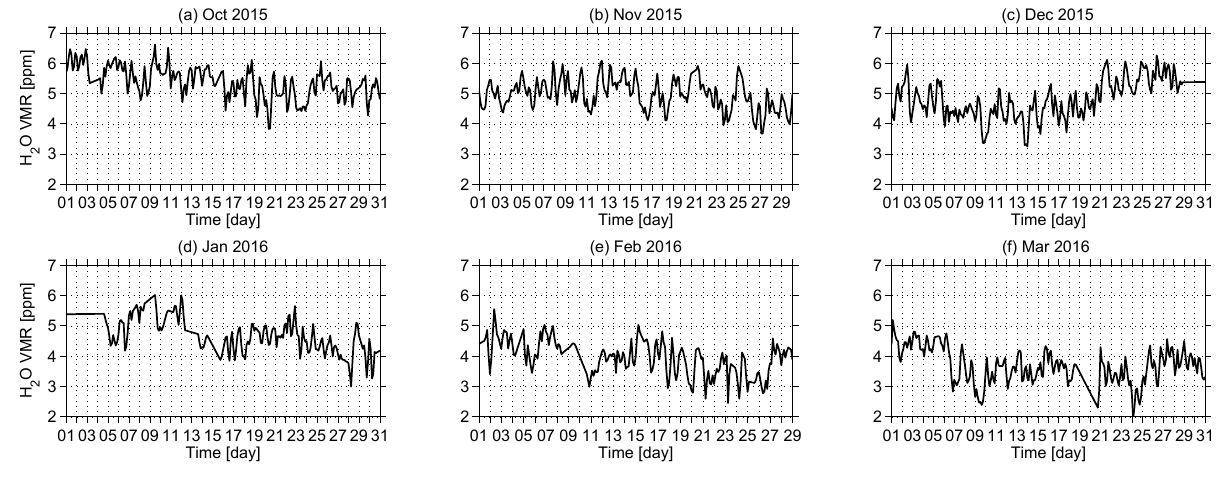
Figure 3. Same as Fig. 2 but for winter